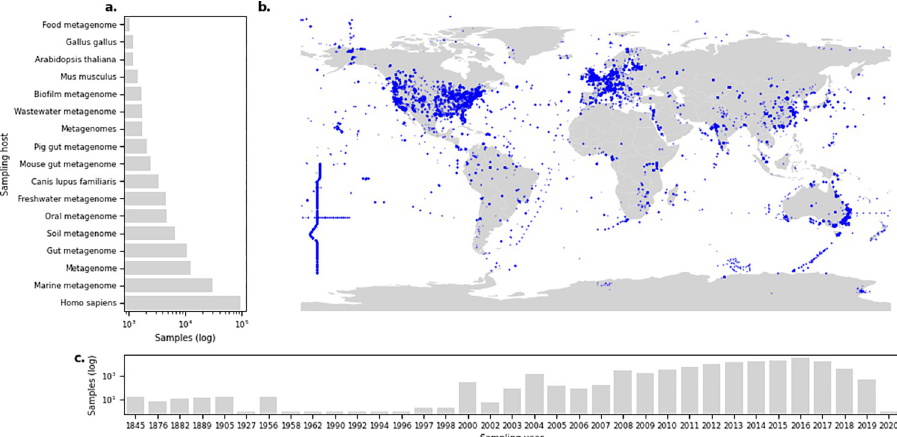
Fig 1. Distribution of metagenomes reveals the overrepresentation of samples from specific sources. (a ) Number of samples grouped per sampling host, where only hosts with more than 1,000 samples are plotted. ( b ) Sample locations for metagenomes with available GPS coordinates; each marker is a sample. A total of 83,903 samples did not have coordinates available. ( c) Year of which a sample was collected. A total of 84,238 of the samples did not have a valid sampling date recorded. The data underlying this figure can be found at https://doi.org/10.5281/zenodo.6919377, and the base layer map was created with data from https://www.naturalearthdata.com/.